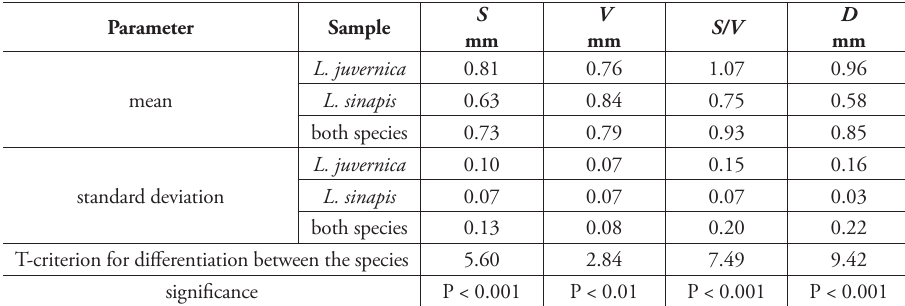
Table 4. The genital measurements of the studied samples of Leptidea spp. The mean values and standard deviations are given of the lengths for the saccus ( S ), valve ( V ) and their ratio ( S / V ) in the male genitalia and the length of the ductus bursae ( D ) in the female genitalia in the studied samples of Leptidea sinapis and L. juvernica , as identified by molecular markers, and the united sample of both species.